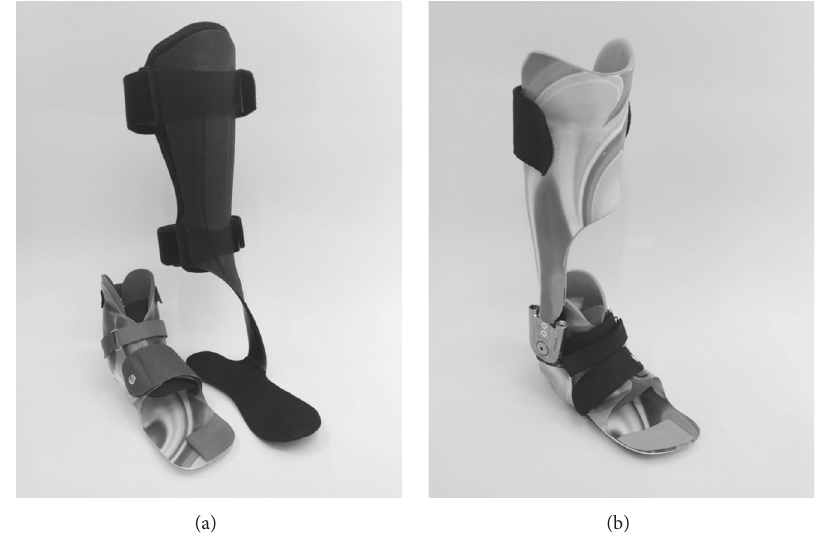
Figure 1: (a) DAFO with ToeOFF adaptation; (b) GRAFO including